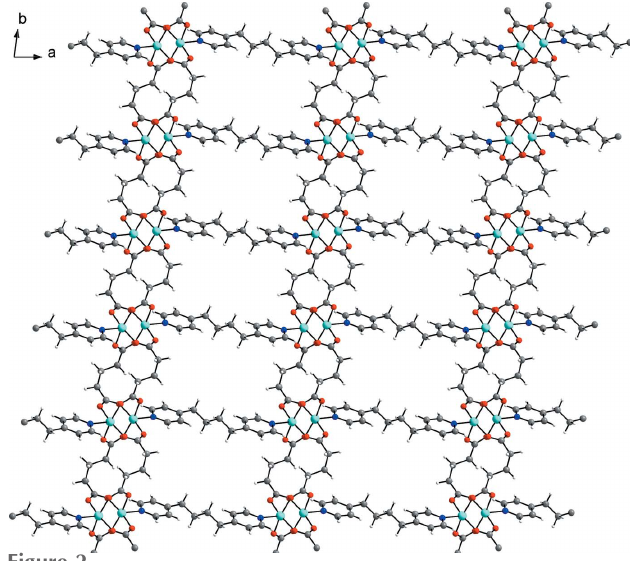
Figure 2 Two-dimensional structure of the title compound. The acetonitrile solvent molecules have been omitted for clarity.